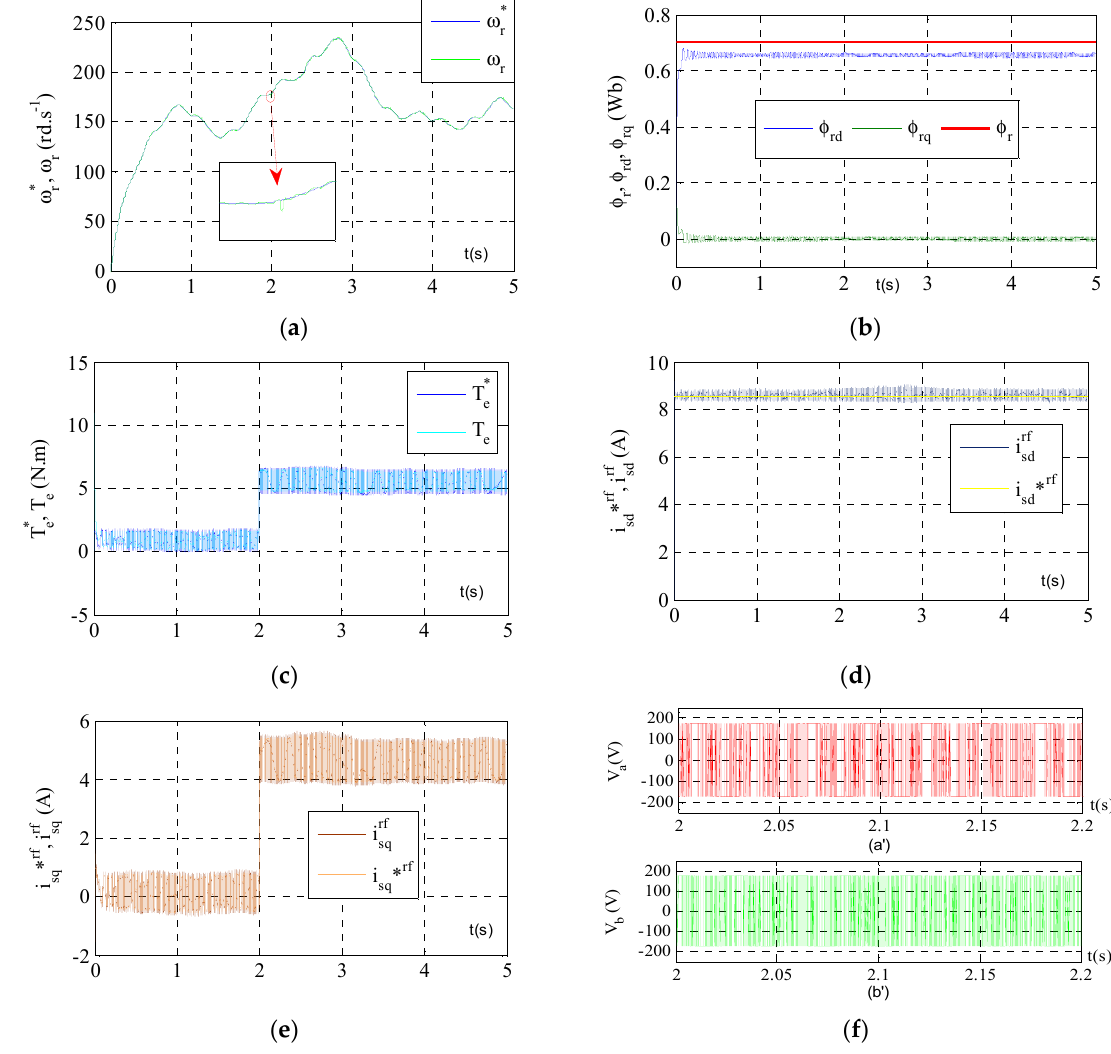
Figure 12. Simulation results of IRFOC TPIM drive fed by an advanced SVM controlled 2 ϕ -inverter under sinusoidal wind speed profile by introducing a load torque at 2 s: ( a ) turbine and TPIM speeds; ( b ) rotor fluxes; ( c ) reference and TPIM electromagnetic torques; ( d ) d-axis reference and actual stator currents; ( e ) q-axis reference and actual stator currents and ( f ) 2 ϕ -inverter output voltages which a’ represents V a and b’ represents V b . “*” means reference quantities as mentioned in Equations (20), (21) and (26).